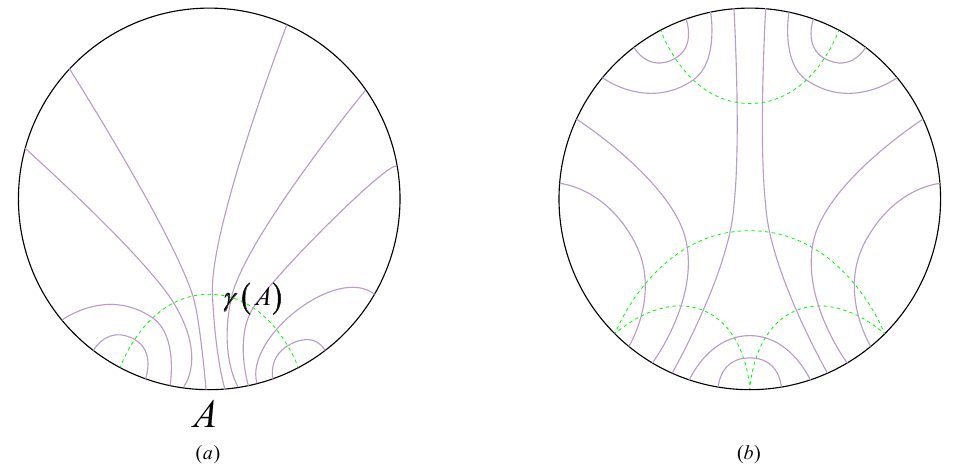
Figure 1 . Two typical examples of locking bit thread configurations, where the mauve lines represent bit threads and the green dashed lines represent RT surfaces. (a) A simplest bit thread configuration locking { A, A c } simultaneously, from which S ( A ) = Flux locking ( A ) . (b) A locking bit thread configuration that can lock a series of non-crossing boundary regions